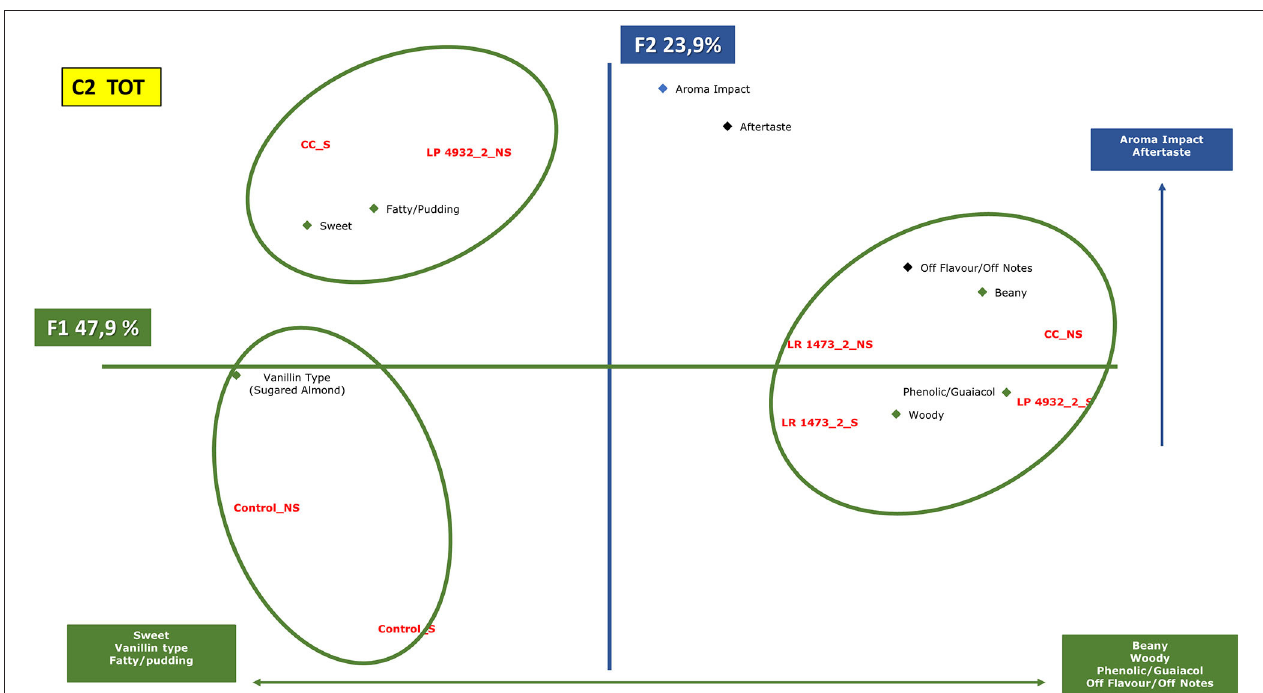
FIGURE 7 | Principal component analysis plot of the similarities and differences in the sensory profiling characteristics of exhausted vanilla beans prepared follow the condition n.2 of DoE and co-culture. CC, co-culture; LP, Lactiplantibacillus plantarum 4932; LR, Lacticaseibacillus rhamnosus 1473; Control, unfermented samples. S: sample with seeds; NS: sample without